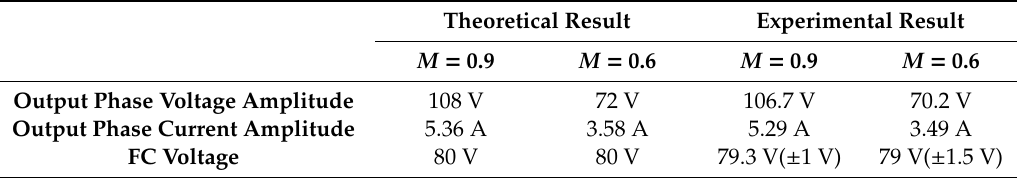
Figure 16. Experimental results of the four-level inverter: ( a ) line to line voltage and three phase currents; ( b ) flying capacitor voltages. Table 6. Comparison of experimental results and theoretical results.